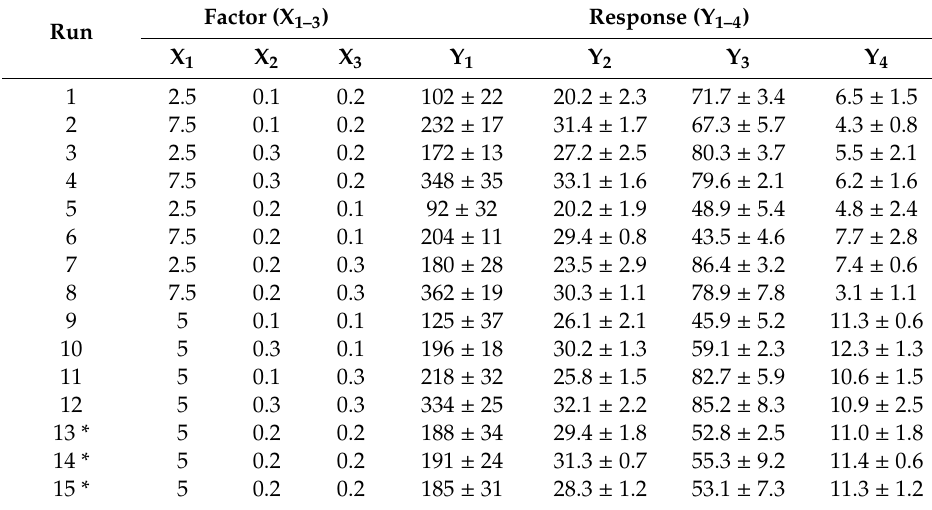
Table 4. Factors and responses of the CG-PEG-CSO-SPIONs in the